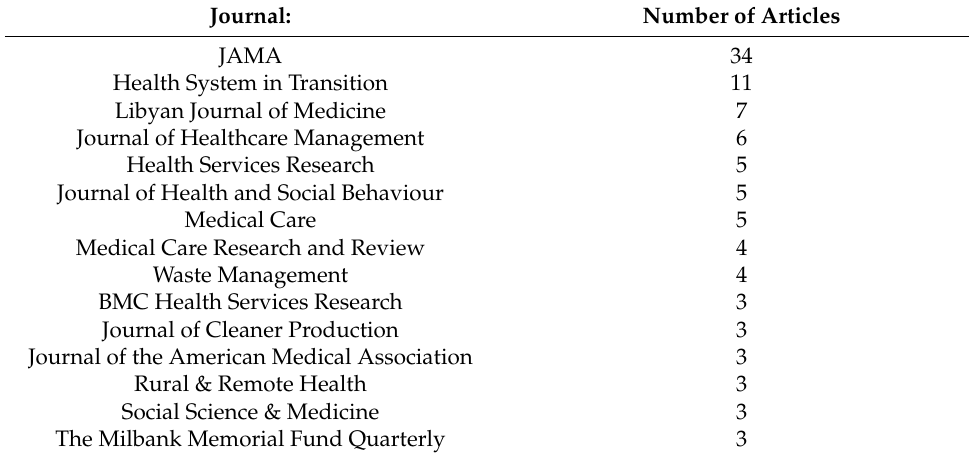
Table 3. The first 15 journals in which healthcare management articles have been published. Journal: Number of Articles